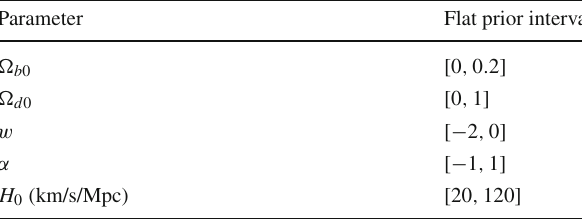
Table 1 Chosen priors for the free parameters Parameter Flat prior